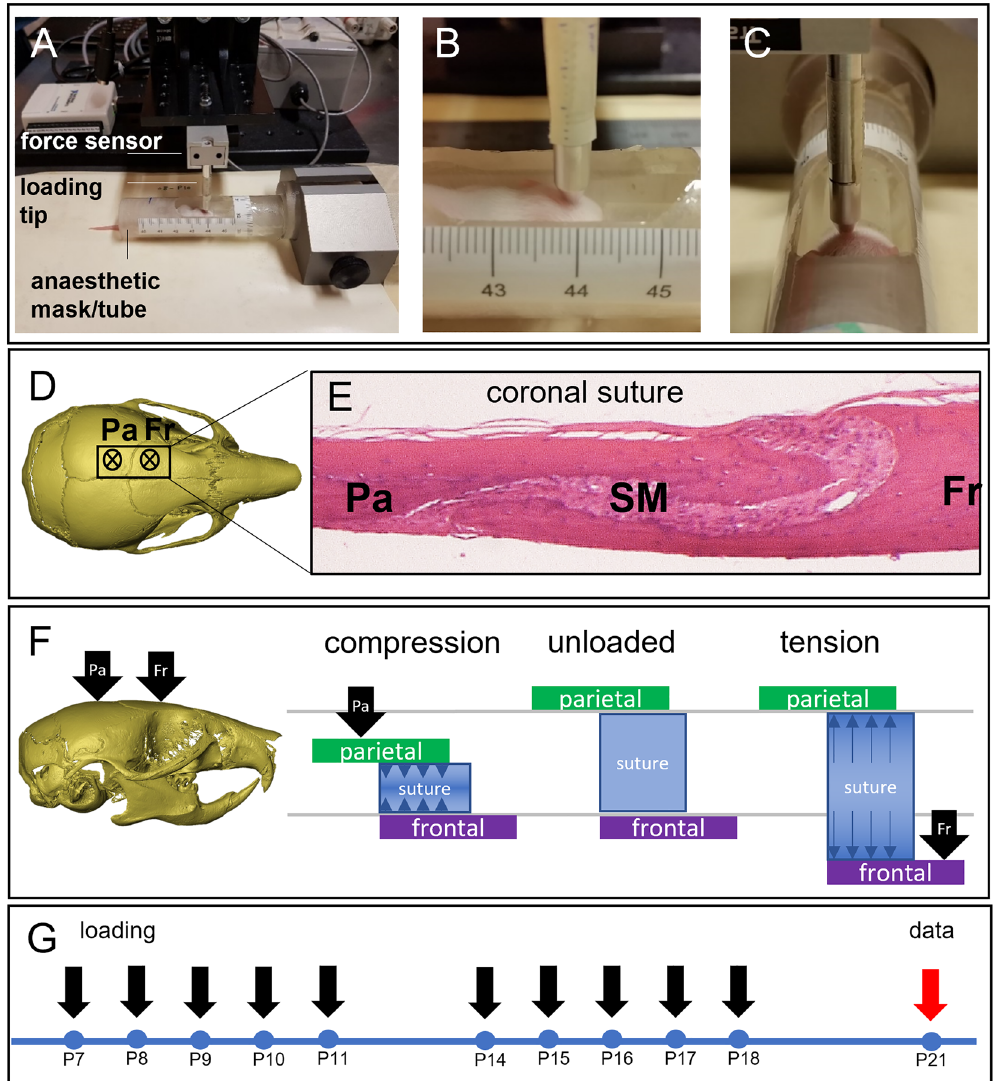
Figure 1. Cranial bone loading on pre-weaning Crouzon mice using actuator technology. ( A ) Equipment set-up showing P10 mouse in a custom-designed, 3D-printed anaesthetic mask and holder, with a window for access to the skull vault. The electrical, linear actuator moves a small probe (1 mm) that loads the bone underneath, a sensor records the force applied. ( B , C ) Close-ups of the loading protocol in progress at postnatal day 7 ( B ) and 21 ( C ) with the actuator probe targeting the frontal bone. ( D ) Top view of a micro-CT generated image of a wild-type mouse skull (P21). The asterisks indicate the approximate loading locations on the parietal (Pa) and frontal (Fr) bones, either side of the coronal suture. ( E ) Histological, sagittal section (H&E) through an adult mouse skull showing the parietal (Pa) and frontal (Fr) bones and the suture mesenchyme (SM) situated between the overlapping parts of the parietal and frontal bones. ( F ) Schematic representation of the mechanical action generated by loading on either the parietal (Pa) or frontal (Fr) bones. Loading the frontal bone will generate tensile forces on the suture (right) and loading the parietal bone will generate compression forces on the suture (left). ( G ) Treatment schedule for the cranial loading protocol starting at P7 and loading 10 days until P18. Skulls are collected at